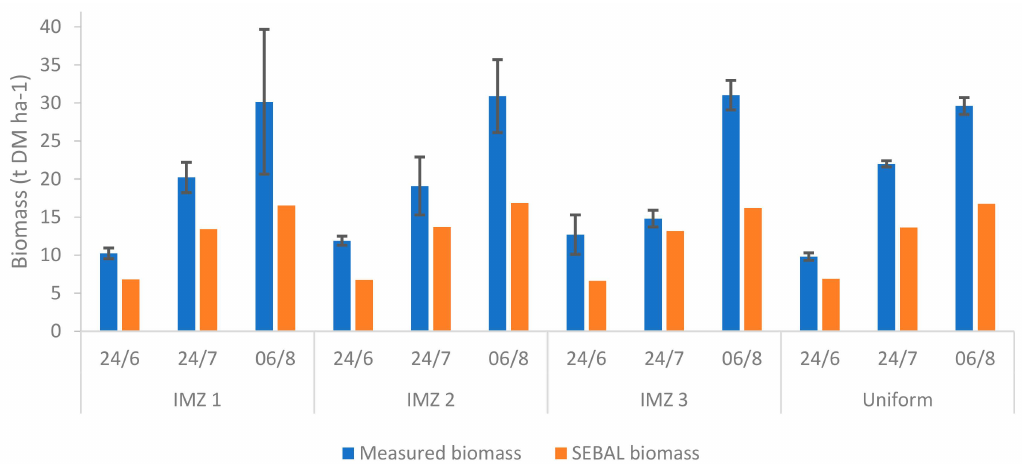
Figure 7. Biomass samples collected at 72 (24 / 6), 102 (24 / 7) and 115 (6 / 8) days after planting (DAP) during the growing season (blue bars) and SEBAL biomass estimates on the same sampling dates for all the zones.